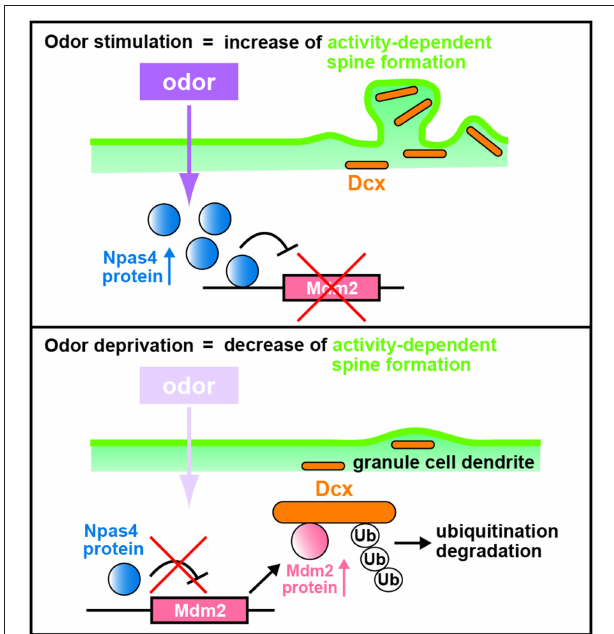
FIGURE 3 | Schematic diagram of dendritic spine formation in newborn OB granule cells regulated by odor inputs. In wild-type olfactory bulb (OB) granule cells (GCs), odor stimulation induces Npas4 expression to suppress Mdm2 expression. The suppression of Mdm2 promotes the spine formation of GC dendrites mediated by doublecortin (Dcx). By contrast, odor deprivation decreases Npas4 expression in OB GCs to upregulate the expression of Mdm2 , leading to ubiquitination of Dcx. This results in degradation of Dcx and reduced dendritic spine density in OB GCs, as in the case of Npas4 -knockout OB GCs (modified from Yoshihara et al.,